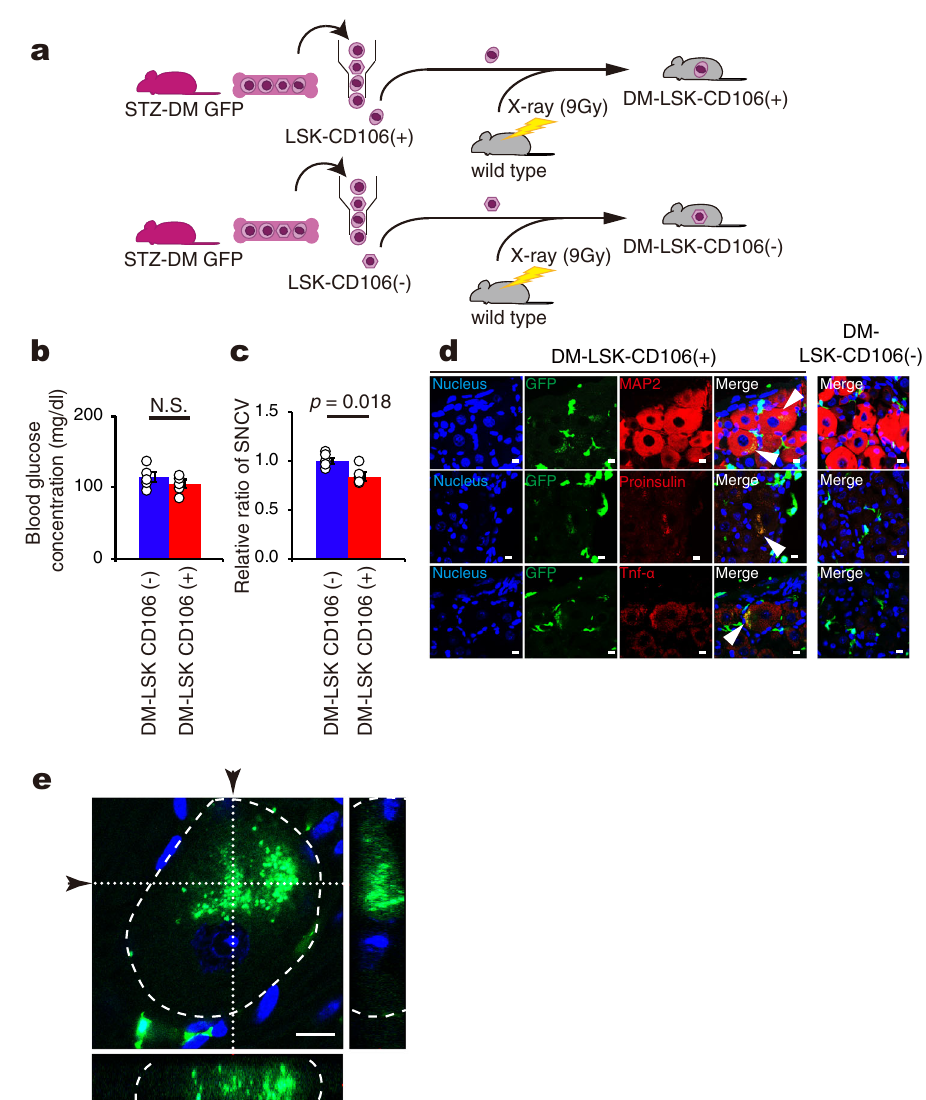
Fig. 5 Cell fusion and development of neuropathy in mice transplanted with LSK-CD106-positive cells from diabetic mice. a A schematic experimental design for the generation of mouse models in this experiment. First, type 1 DM was induced in GFP-Tg mice by intravenous STZ injection (STZ-DM GFP). Three months later, 9 Gy lethally-irradiated normoglycemic wild type mice were transplanted with LSK-CD106-positive or -negative cells obtained from STZ-DM GFP (DM-LSK-CD106 ( + ) BMT, DM-LSK-CD106 ( − ) BMT, respectively). b Blood glucose concentration of DM-LSK-CD106( + ) BMT ( n = 5) and DM-LSK-CD106 ( − ) BMT ( n = 5). N.S means not signi fi cant. c Relative ratio of sensory nerve conduction velocity (SNCV) of the sciatic nerve in DM- LSK-CD106 ( + ) BMT ( n = 5) and DM-LSK-CD106 ( − ) BMT ( n = 5). d Immuno fl uorescent staining of dorsal root ganglia (DRG) in DM-LSK-CD106 ( + ) BMT and DM-LSK-CD106 ( − ) BMT and for the nucleus (blue), GFP (green), MAP2 (red), proinsulin (red), and TNF- α (red), and merged images. Arrowheads showed fusion cells. e Z-stack imaging of DRG from DM-LSK-CD106( + ) BMT. Narrow images indicate the cross-section of x -axis or y -axis (whited dotted line) in DRG neuron surrounded by white dashed line. Arrows indicate the position of cross-section. Green showed GFP. Blue showed nucleus. Scale bar = 10 μ m. Data are indicated as means ±